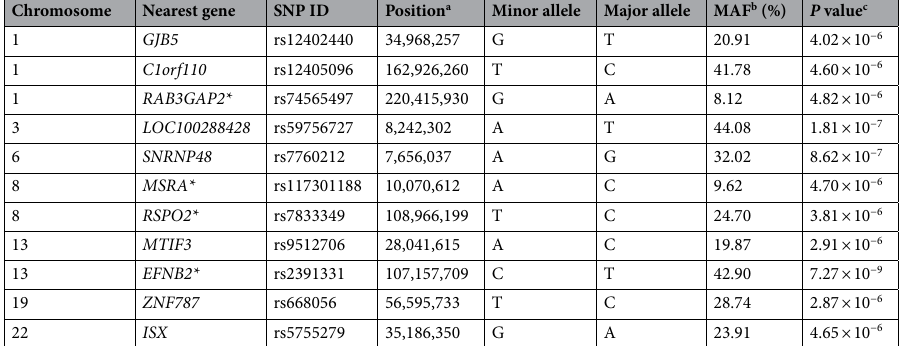
Table 3. Interactions between individual single nucleotide polymorphisms (SNPs) and 7 environmental factors. a Chromosomal positions are based on the 1000 Genomes Project’s haplotype phase 1 in NCBI build 37 (hg19). b MAF is minor allele frequency. c The P value for the effects of interaction between genotypes and environmental factors on BMI were assessed by using a Struct-LMM with adjustment for age, sex, and recruitment area. The nearest gene to which the SNP is